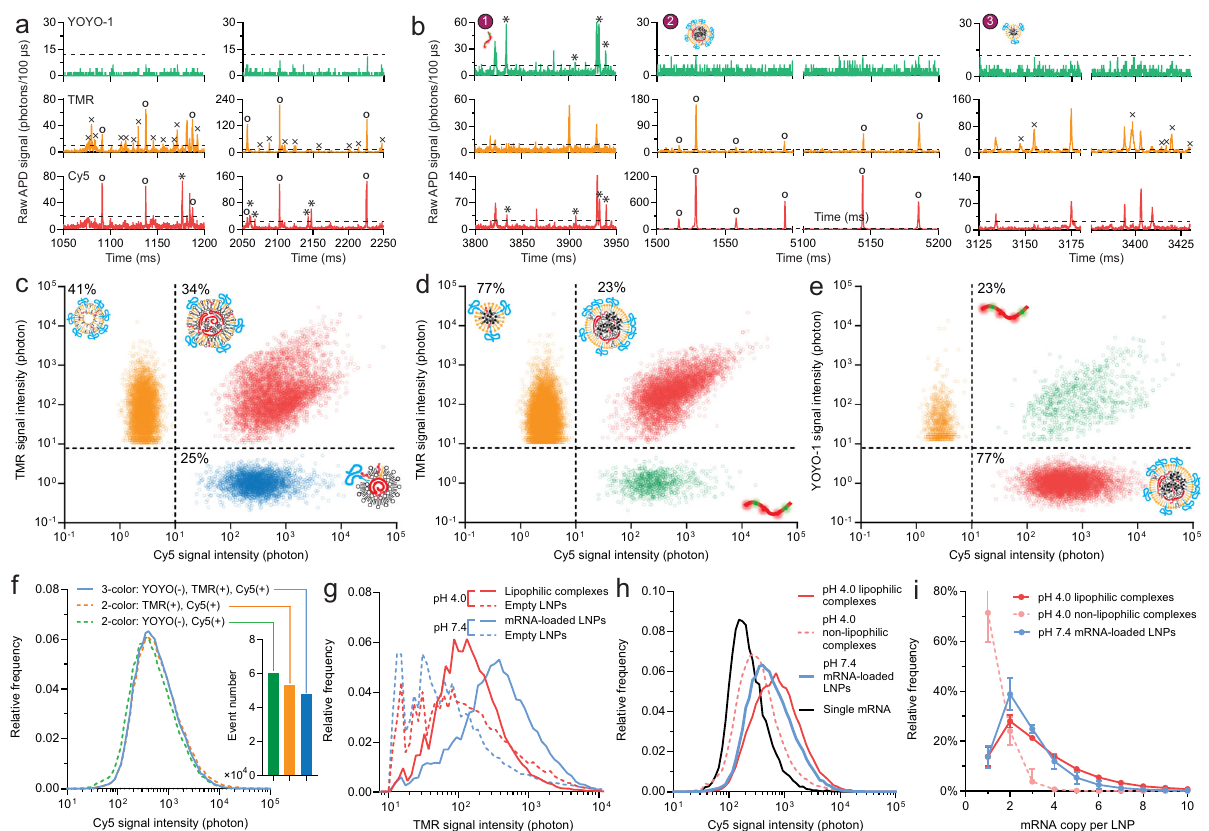
Fig.2|mRNApayloadbehaviorsofabenchmarkmRNALNPformulation(DLin- MC3-DMA: DSPC: cholesterol: DMG-PEG=50:10:38.5:1.5). a Example of 3-color raw signals at pH 4.0. Circles label events of lipophilic complexes; Asterisks label eventsofnon-lipophiliccomplexes;crosseslabeleventsofemptyLNPs. b Example of three-color raw signals upon dialysis to pH 7.4. Asterisks label events of free mRNAs in panel 1; Circles label events of mRNA-loaded LNPs in panel 2; Crosses labelevents of empty LNPs inpanel3. a , b The dashed linesshow the threshold set fordetection. c Classi fi cationofLNPspeciesintoemptyLNPs(upper-leftquadrant), lipophilic complexes (upper-right quadrant) and non-lipophilic complexes (lower- right quadrant) by plotting TMR signal intensity against Cy5 signal intensity at pH 4.0. 10% of 141,530 signals are shown in the fi gure. d Classi fi cation of LNP species intoemptyLNPs(upper-leftquadrant),mRNA-loadedLNPs(upper-rightquadrant), and free mRNAs (lower-right quadrant) detected at pH 7.4. For clarity, 10% of 195,090 signals are shown in the fi gure. The percentages labeled are relative to all